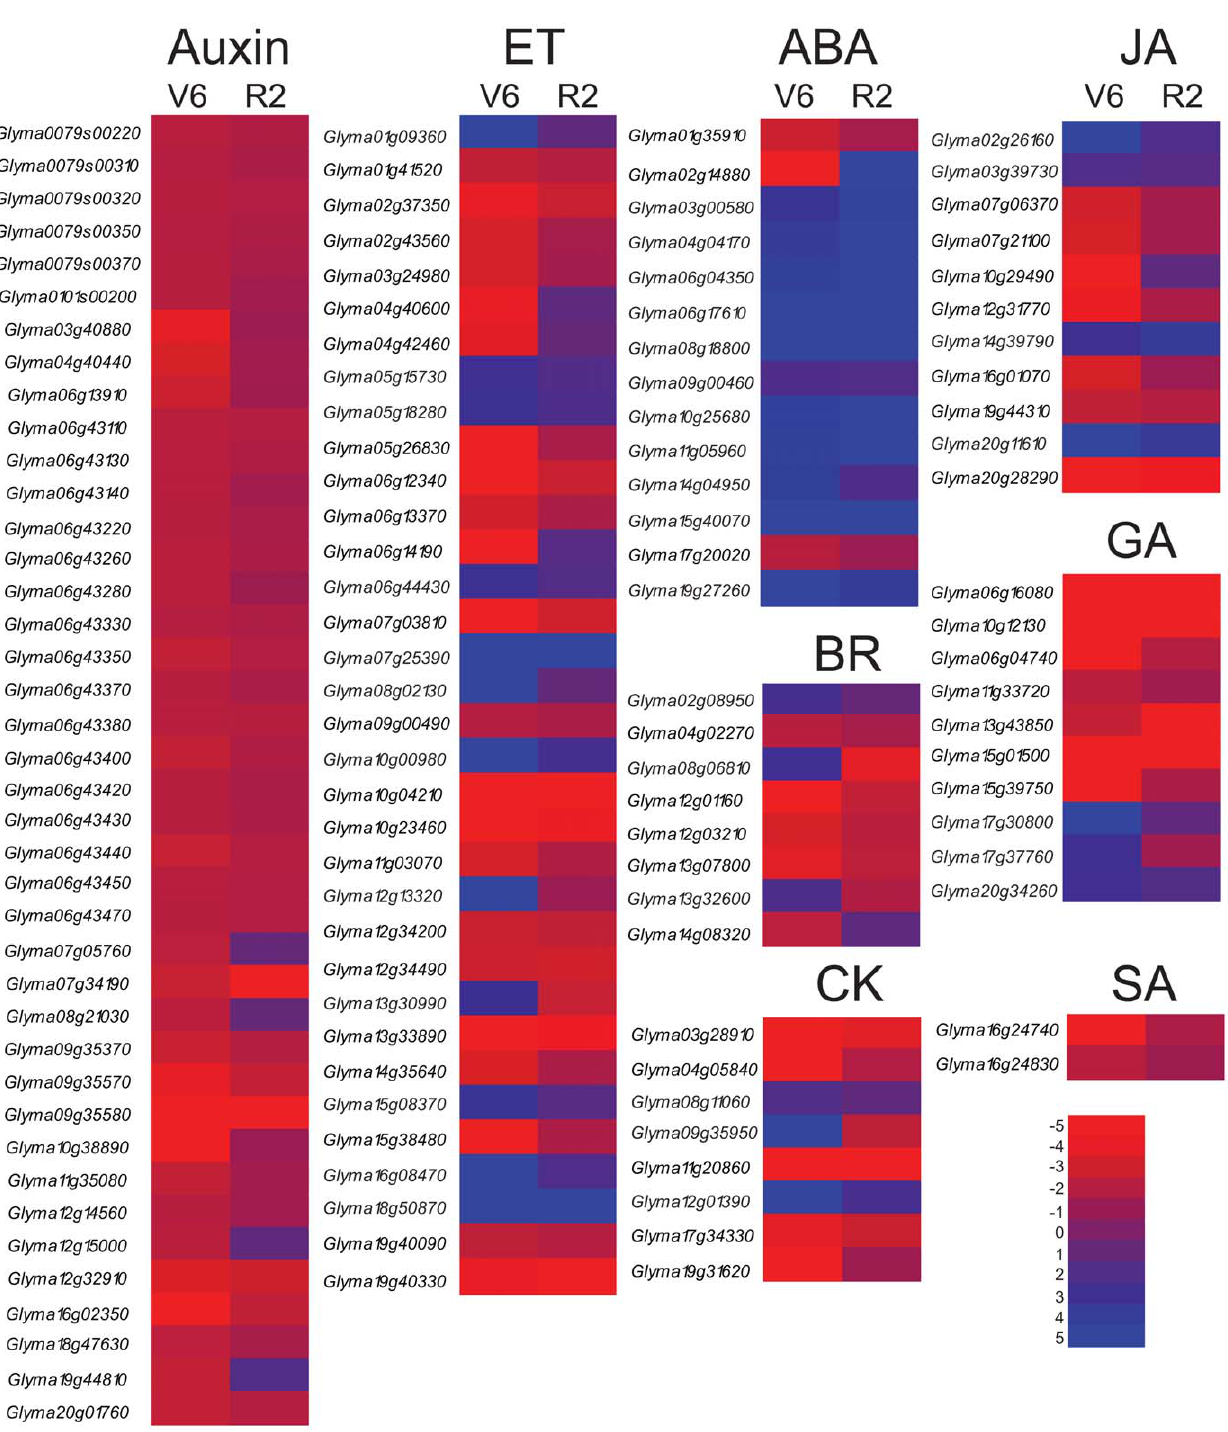
Figure 3. Heatmap analysis of hormone-related genes differentially expressed in soybean V6 and R2 leaves under drought stress. Genes shown are either up-regulated or down-regulated at least by two-fold. Blue and red color gradients indicate an increase or decrease in transcript abundance, respectively. Auxin (IAA, indole-3-acetic acid), ethylene (ET), ABA, jasmonate (JA), giberelline (GA), brassinosteroid (BR), cytokinin (CK) and salicylic acid (SA). doi:10.1371/journal.pone.0049522.g003 finding is consistent with previously published results as photo- With regard to the downregulated gene sets, the major synthesis is negatively affected by various stresses, including difference found between the up- and downregulated gene sets drought [12,32–34]. The downregulation of photosynthesis-re- was that many photosynthesis-related genes were down-regulated lated genes, which contribute to, at least in part, growth under drought stress in both two comparisons (Figure 2). This